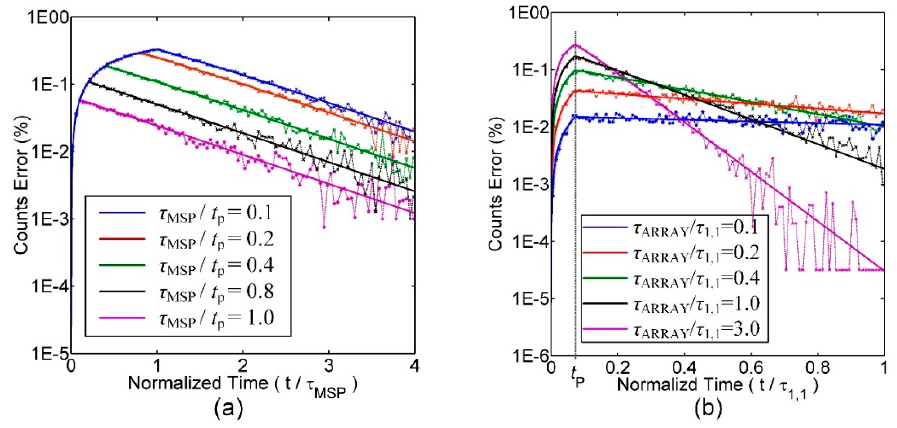
Figure 7. ( a ) The counts errors of events along normalized time under different τ MSP / t p ; ( b ) the counts errors of events along normalized time under different τ ARRAY / τ 1,1 .